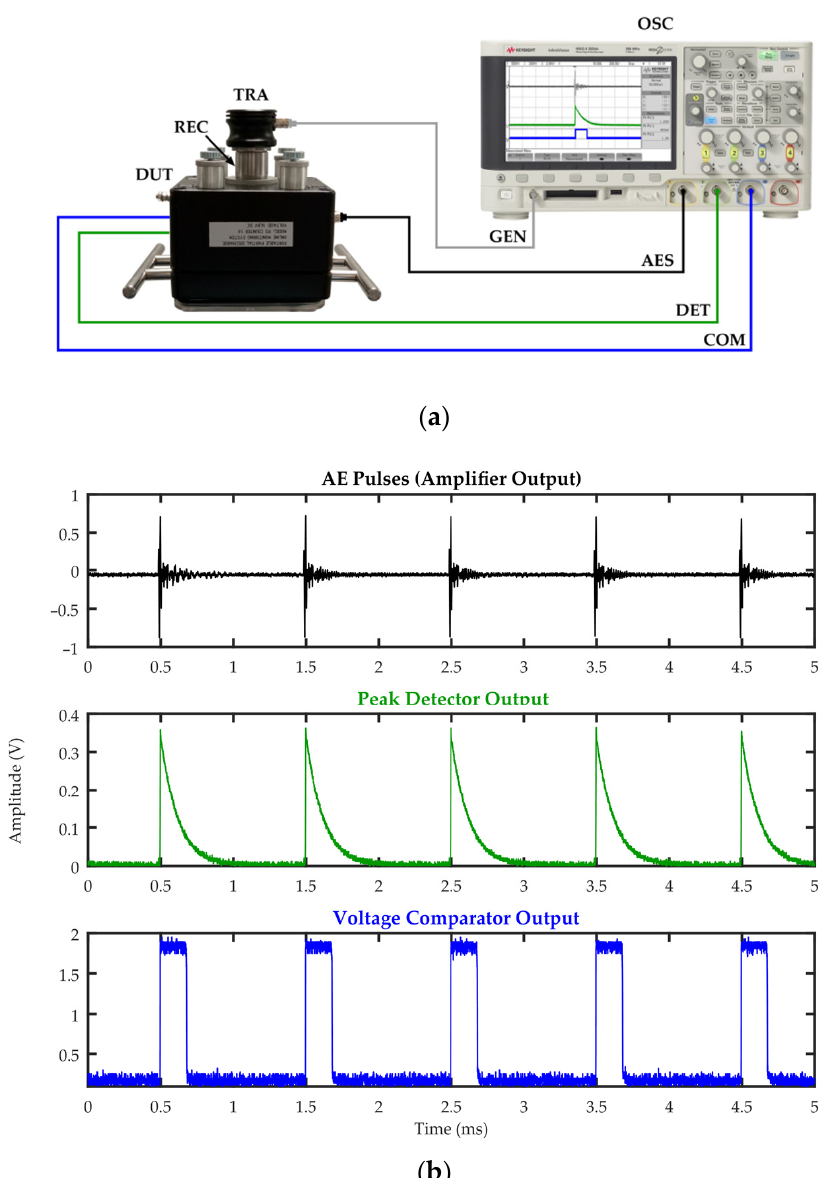
Figure 5. Testing of individual electronic modules of the PD monitoring system; ( a ) schematic diagram of the measurement system: TRA—wideband piezoelectric transducer Olympus V101B for generating AE pulses (transmitter), REC—piezoelectric transducer of the monitoring system (receiver), DUT—system under test, OSC—oscilloscope Keysight DSOX2024A, GEN—signal generator, AES—signal recorded at the output of the amplifier, DET—signal recorded at the output of the peak detector; COM—signal recorded at the output of the voltage comparator; ( b ) waveforms recorded at the output of the amplifier, peak detector, and voltage comparator, respectively.